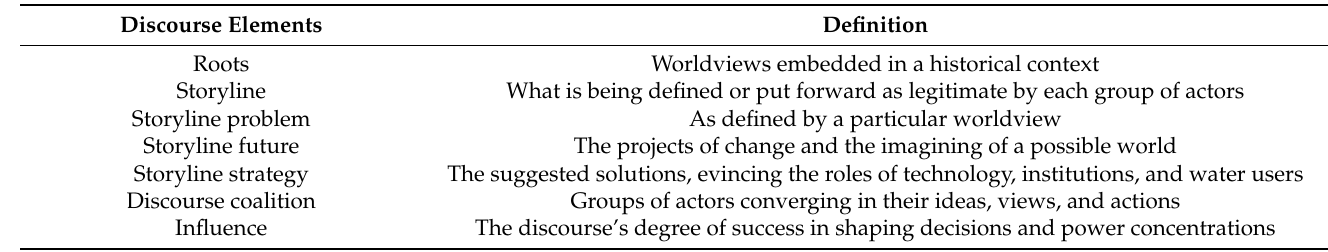
Table 1. Structure * of the analytical